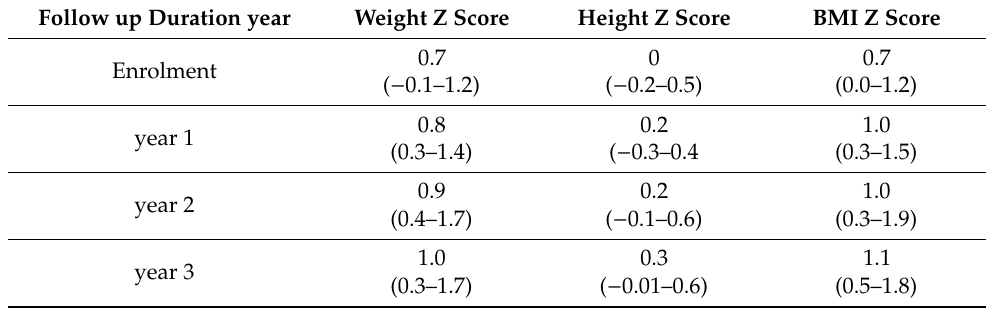
Table 5. Median (range) annual weight, height and BMI Z scores for all children at enrolment and follow up at year